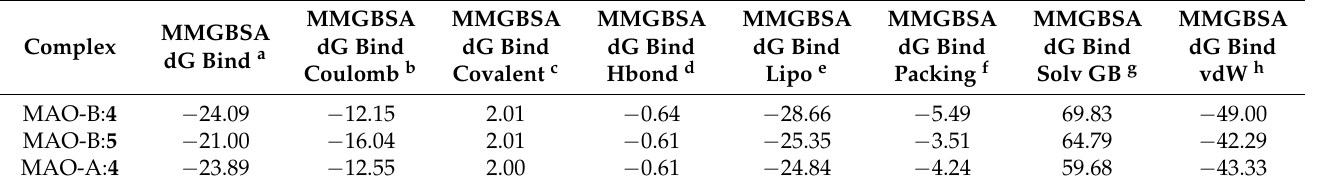
Figure 4. ( A ) RMSD evolution during the MD simulation of the protein (light blue, calculated on the C-alpha, left Y -axis) and the ligand (compound 4 ) (pink, calculated on all atoms, right Y -axis). ( B ) Protein RMSF; green lines indicate residues interacting with ligand 4 . ( C ) The 2D representation of most conserved ligand–protein interactions with the indication of the persistence (%) along the simulation; ( D ) depiction of frequency and type of ligand–protein interaction along with the MD simulation. Ligand 4 forms mainly hydrophobic contacts with the protein. Table 4. MM-GBSA calculated binding energies for the frames extracted from the MD simulation of the three